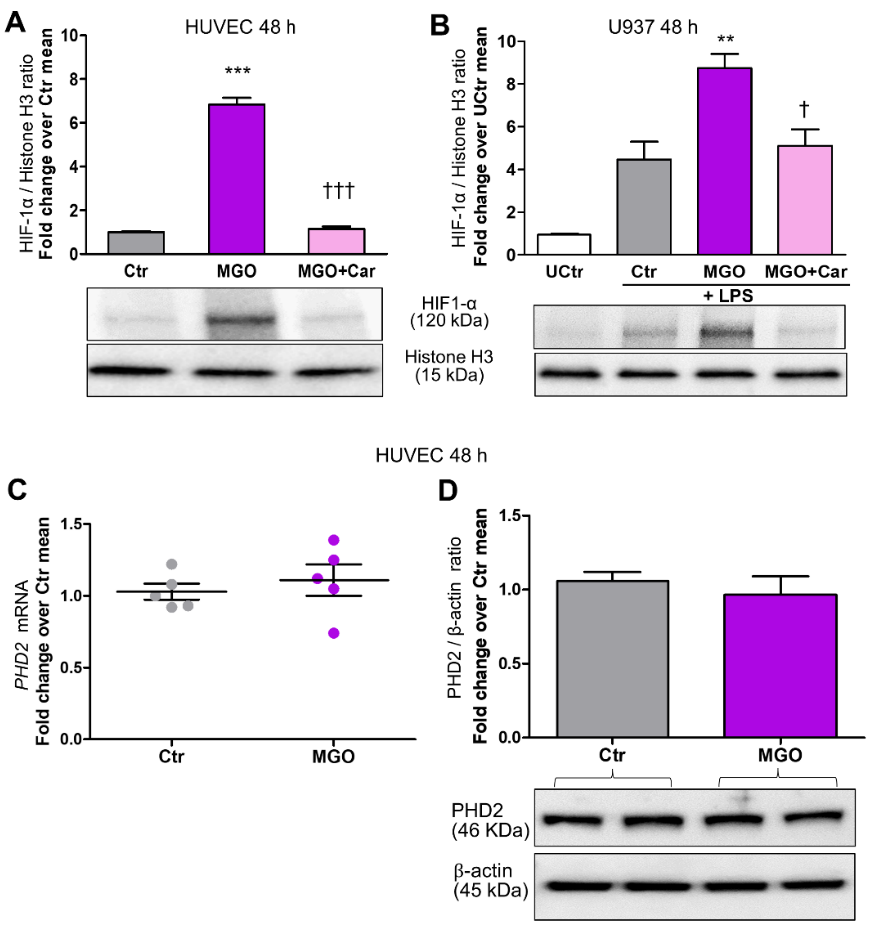
Figure 3. The glycolytic side-product MGO increases HIF-1 α nuclear translocation in endothelial cells and LPS-stimulated macrophages but does not affect mRNA and protein levels of PHD2. Western blot analysis for HIF-1 α in nuclear extracts from HUVEC ( A ) and U937 cells stimulated (or not, UCtr = untreated control) with LPS (10 ng/mL) ( B ), treated or untreated (Ctr) with the reactive dicarbonyl compound MGO (200 µM) for 48 h, in the presence or absence of the carbonyl trapping agent Car (20 mM), and relative band densitometry analysis from three separate experiments. PHD2 mRNA (( C ), n = 5) and protein levels in total extracts ( D ), from HUVEC treated or untreated (Ctr) with MGO (200 µM) for 48 h, and relative band densitometry analysis from three separate experiments. Each dot in ( C ) represents the mean of two individual technical replicate. Bars represent mean ± SEM. Post hoc multiple comparison: *** p < 0.001 or ** p < 0.01 vs. Ctr; ††† p < 0.001 or † p < 0.05 vs. MGO.